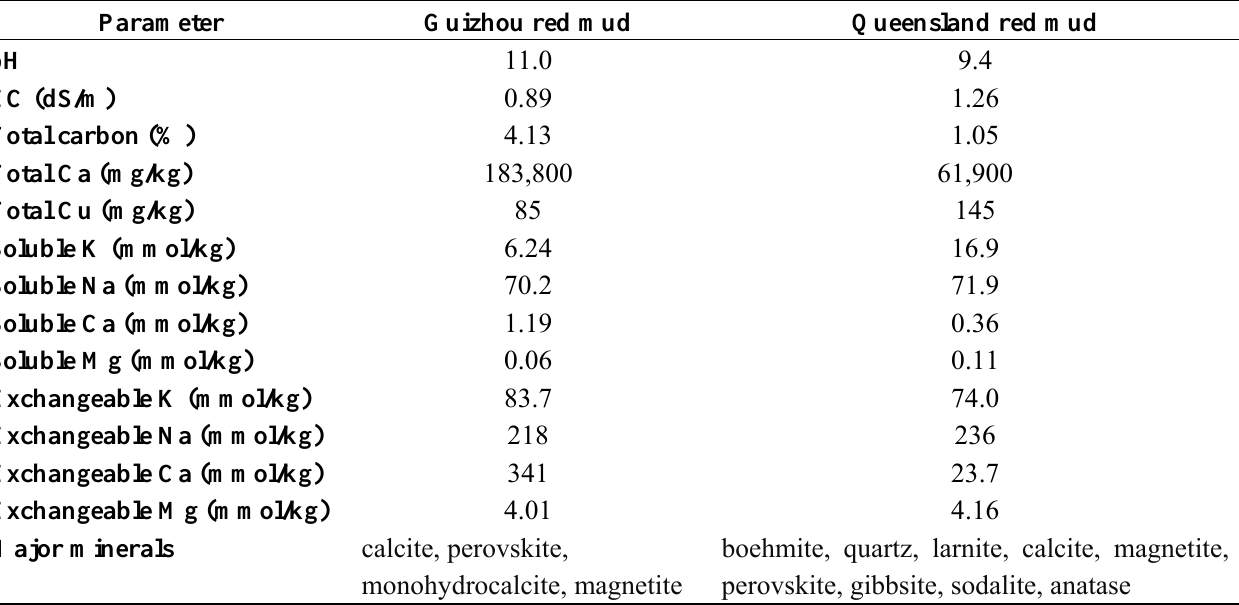
Table 1. Some major chemical and mineralogical parameters of the two red mud types used in the